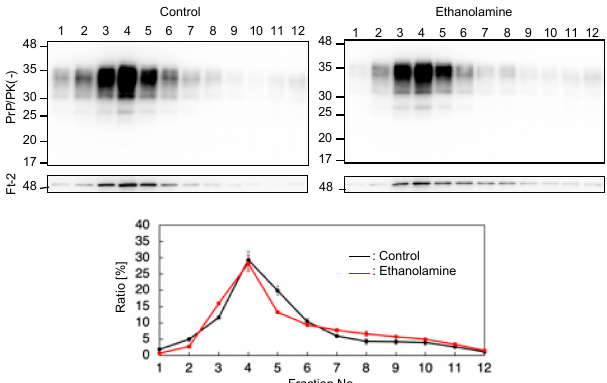
Figure 5. Ethanolamine does not affect the localization of PrP C at lipid rafts. Upper panels: Western blotting with 6D11 anti-PrP antibody of cell lysates from N2aC24 cells cultured in classic DMEM supplemented with ethanolamine (100 μ M) for 6 days after fractionation by the sucrose density gradient assay. Flotillin-2 is the lipid raft marker. Lower panel: Densitometric analysis of PrP C levels from triplicate experiments.